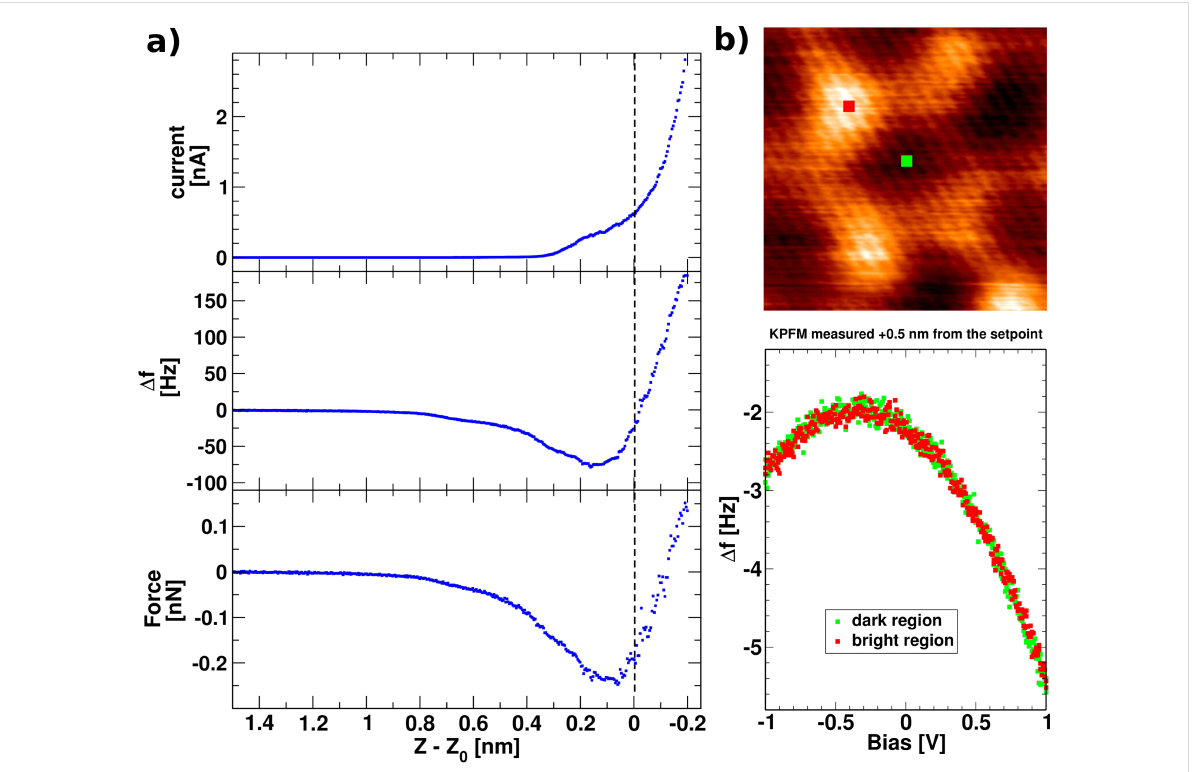
Figure 2: (Color online) (a) Spectroscopy curves of average tunneling current < I t >, Δ f and force F vs the tip–sample distance on graphene/SiC(0001), taken with a bias voltage of 100 mV, just before imaging. The value of Z = 0 corresponds to the tip–sample separation at < I t > setpoint of 0.46 nA. (b) Example measurements of the local potential at bright and dark regions of the q-(6 ) modulation visible in the Δ f map, indicating undetectable charge transfer.